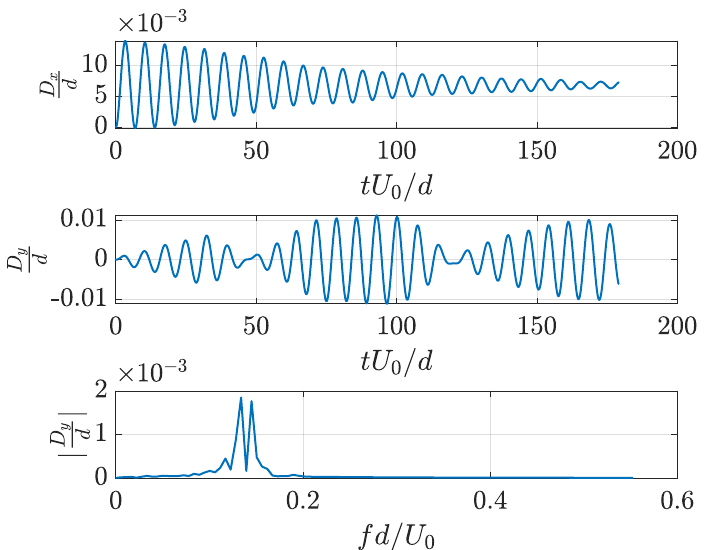
Figure 8. Time record of the displacement of the edge of the cylinder: displacement in the direction of motion ( top panel); displacement in the transversal direction ( middle panel); spectrum of the transverse displacement ( bottom panel); time record in the time interval 0–180 tU 0 / d .